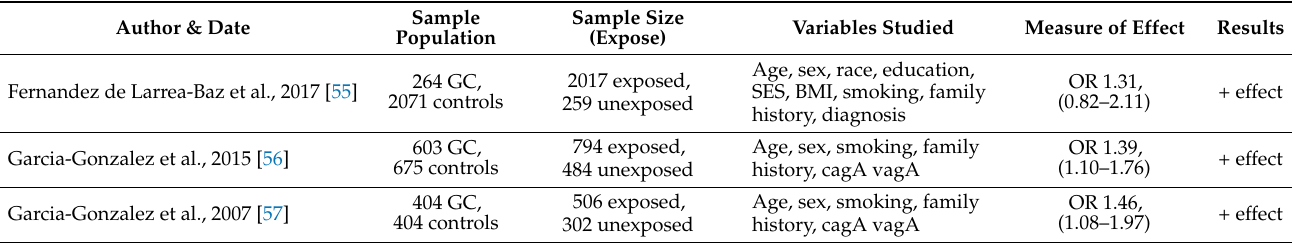
Table 2. Causal association of H. pylori and gastric cancer in Spanish studies. Table 2 . Causal association of H. pylori and gastric cancer in Spanish studies.